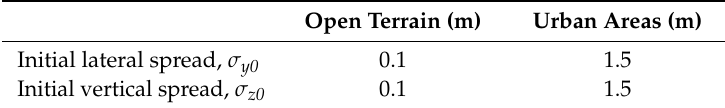
Table A2. Initial spread values required by reference model for open terrain and urban